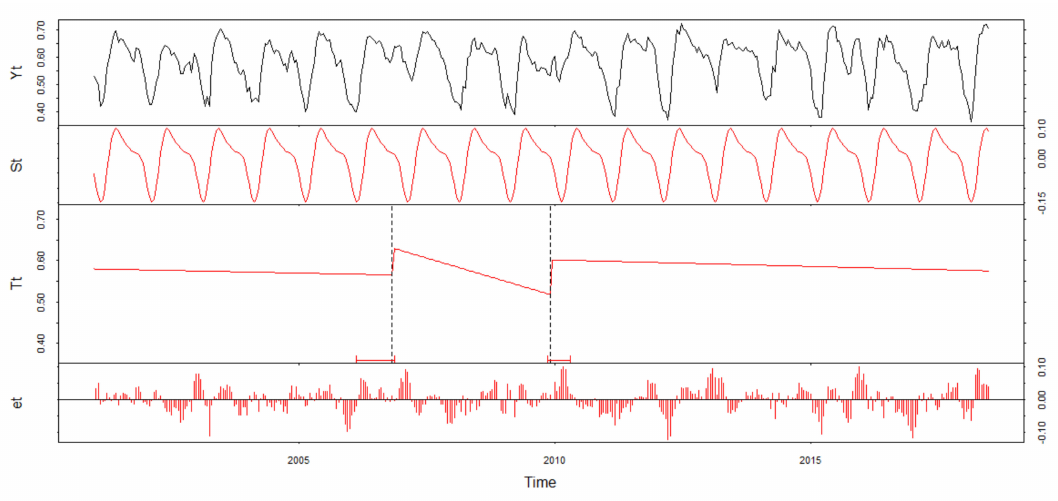
Figure 14. bfast mean 16-day NDVI time series decomposition (2001–2018). Breakpoints in trend were found between 2006 and 2010.